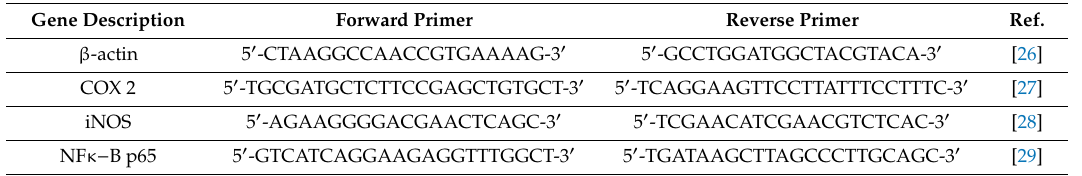
Table 1. Primers used for